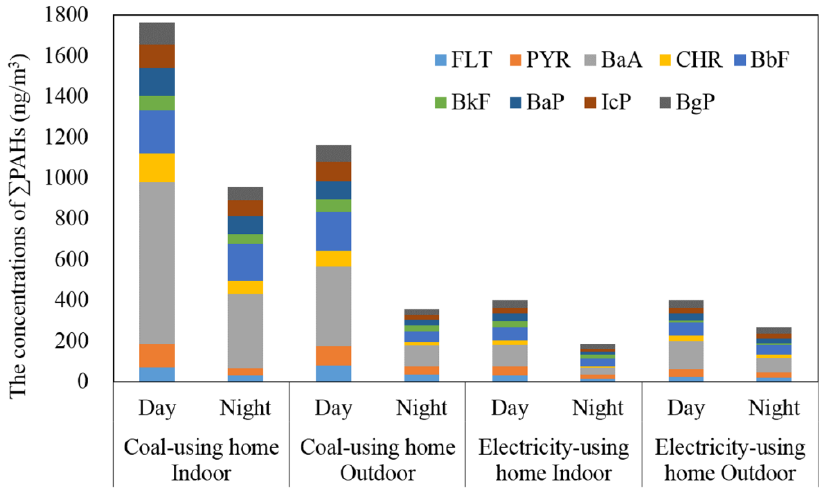
Figure 3. Mass concentration distribution of PAHs in PM 2.5 samples from the homes in the Hutou village of the Laibin town, Xuanwei city.